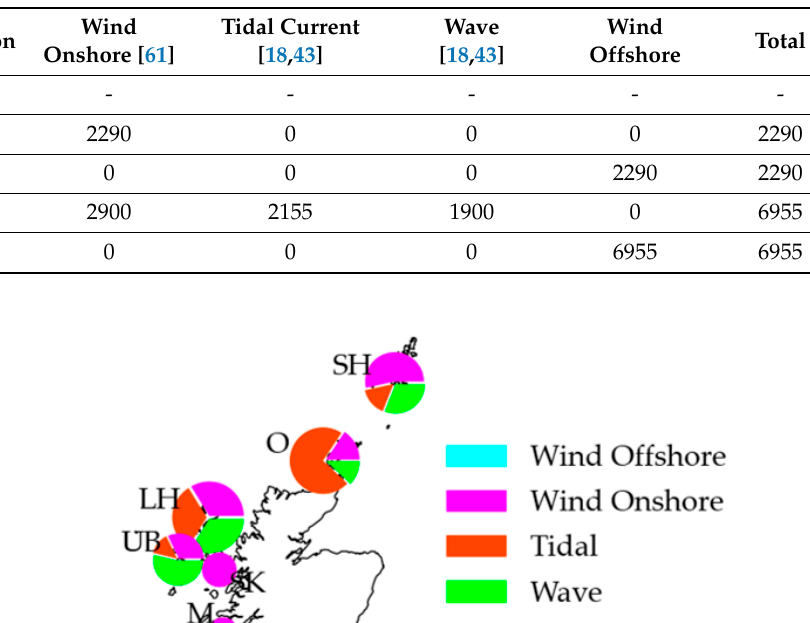
Table 3. Capacity installed (MW) additional to the BAU scenario.